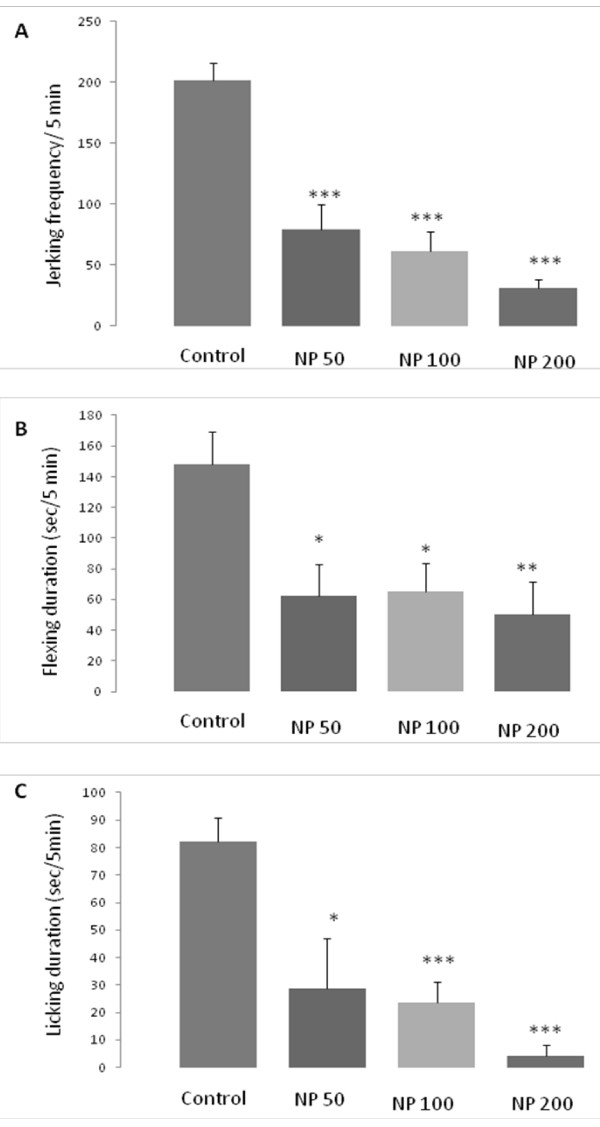
Antinociceptive effects of different doses of the essential oil of Nepeta pogonosperma (NP) in the early phase of formalin test (minutes 0 – 5). NP doses reduced different pain behaviors including jerking (A), flexing (B) and licking (C). Each bar symbolizes for mean ± S.E.M. for 6 rats. * = p <0.05, ** = p <0.01, *** = p <0.001 compared to control.